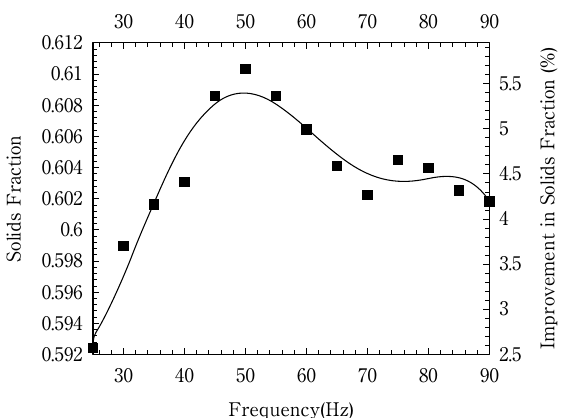
Fig. 7 Solids fraction behavior versus frequency at a/d = 0.08 and N =